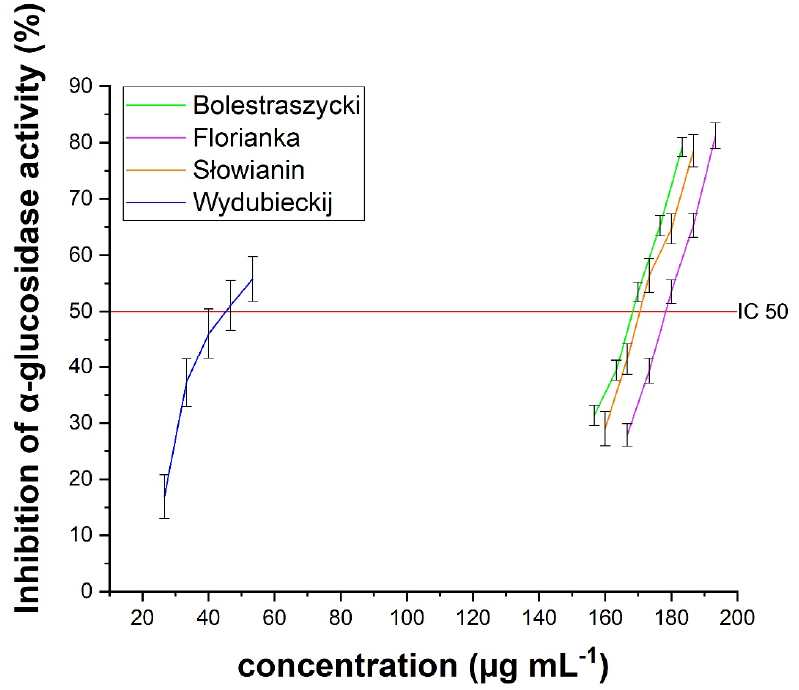
Figure 3. The α -glucosidase inhibitory activity of Corni fructus water extracts. Significance with p ≤